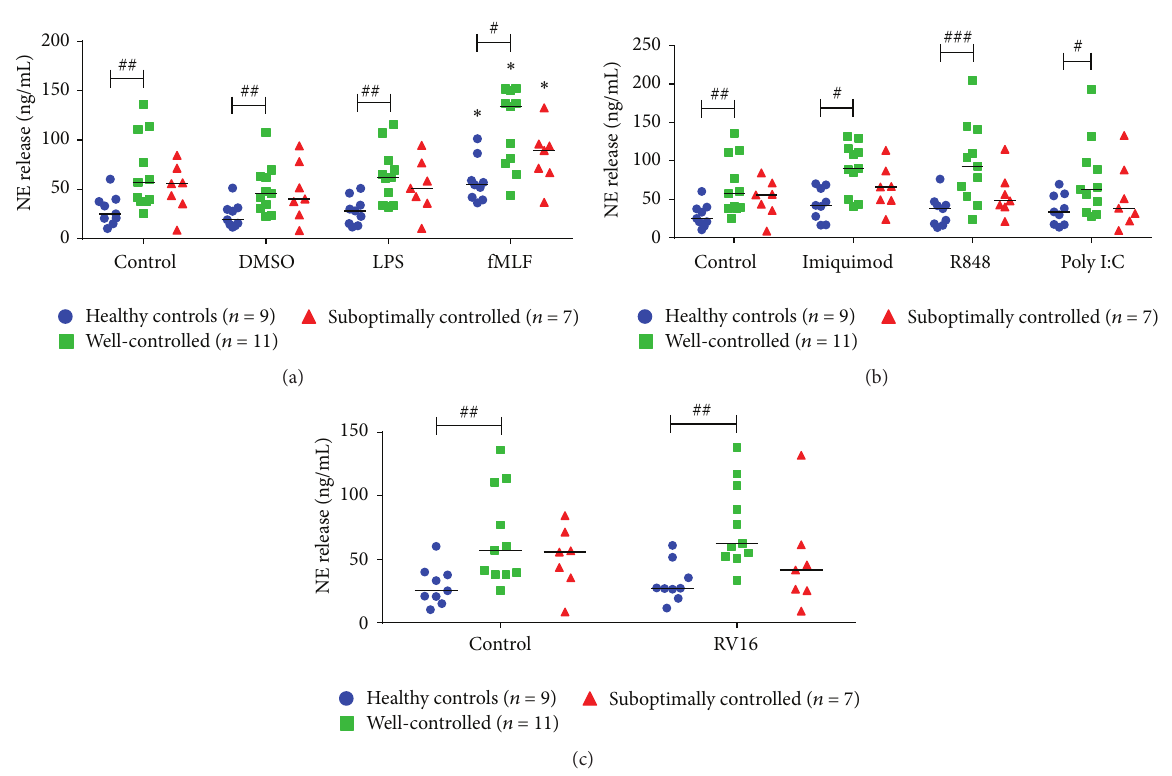
Figure 2: NE release from neutrophils stimulated with bacterial and viral mimetics and RV16. NE release from healthy controls (blue circles, 𝑛 = 9 ), well-controlled asthmatic (green squares, 𝑛 = 11 ), and suboptimally controlled asthmatic (red triangles, 𝑛 = 7 ) neutrophils stimulated with (a) bacterial compounds: lipopolysaccharide (LPS), f-Met-Leu-Phe (fMLF), and DMSO (vehicle control), (b) viral surrogates: imiquimod, R848, and polyinosinic:polycytidylic acid (poly I:C), and (c) RV16 after 1 hour. Raw data is presented as a scatter plot with median. ∗ 𝑝 < 0.05 compared to unstimulated control. # 𝑝 < 0.05 , ## 𝑝 < 0.01 , and ### 𝑝 < 0.001 between indicated disease